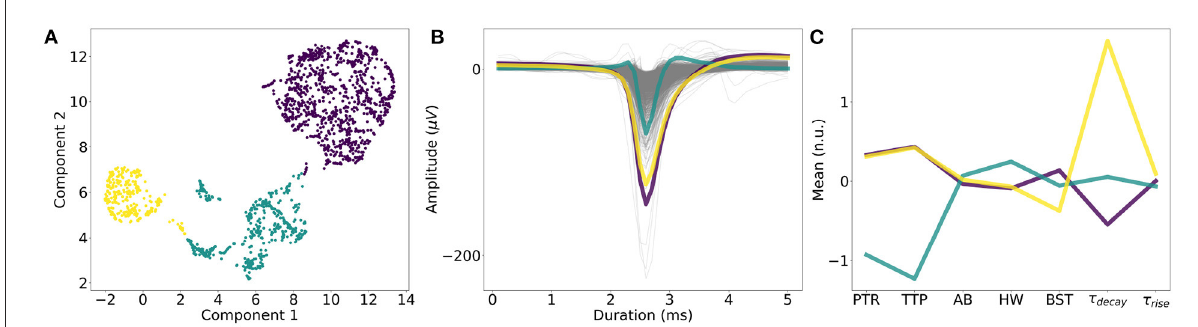
FIGURE2 Single-neuron waveform features. (A) k -means clustering of dimensionality-reduced (UMAP) single-neuron features. k = 3 (number of clusters) yielded the best silhouette score. (B) Average waveforms and single-neuron features for each cluster. (C) One cluster (in cyan) showed smaller average PTR (“Peak-to-trough”) and TTP (“Trough-to-peak”) values, compared to the other two clusters (yellow and purple), while the other two clusters mainly differed in “ τ decay ,” which is the time constant characterizing the downward slope of the ACG. “AB,” “HW,” “BST” denotes “AB ratio,” “Halfwidth,” and “Burstiness.” respectively. “ τ rise ” is a measure of the upward slope of the ACG.